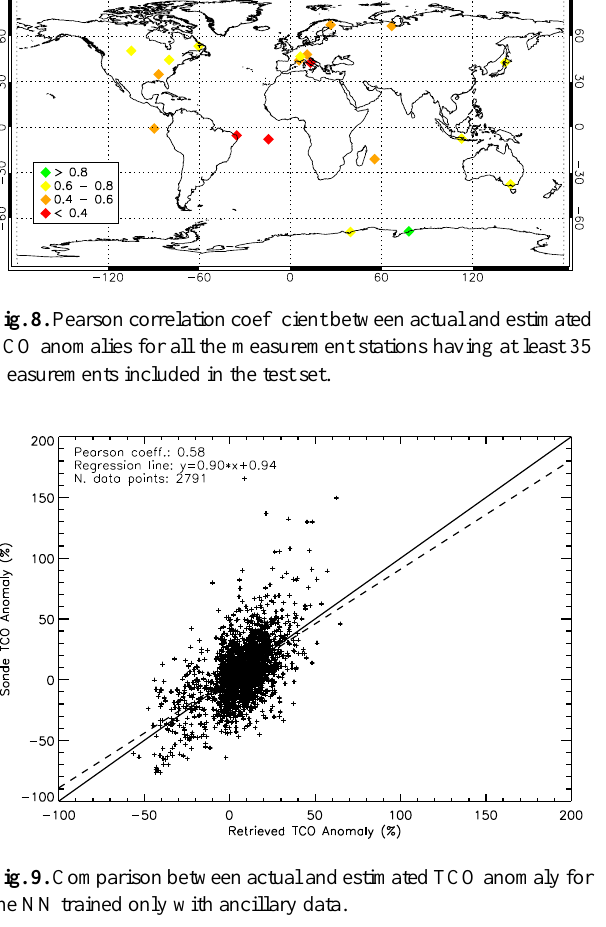
(CTM) TM5 (Krol et al., 2005; Williams et al., 2012). The model provided simulated ozone fields at 34 pressure lev- els, on a grid of 3 ◦ in longitude by 2 ◦ in latitude. In order